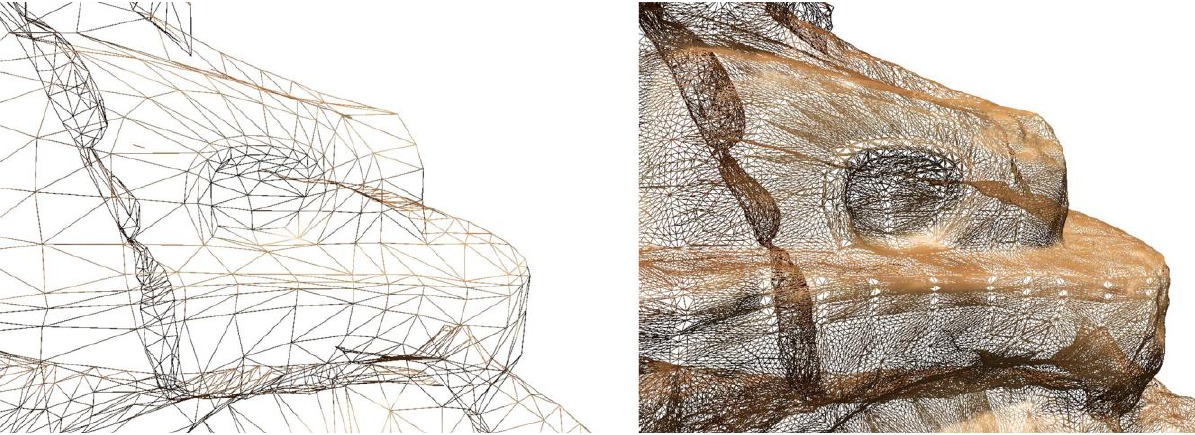
Figure 13. Comparison between the geometry of the original low-poly mesh (left) and the results of applying it the proposed tessellation shader